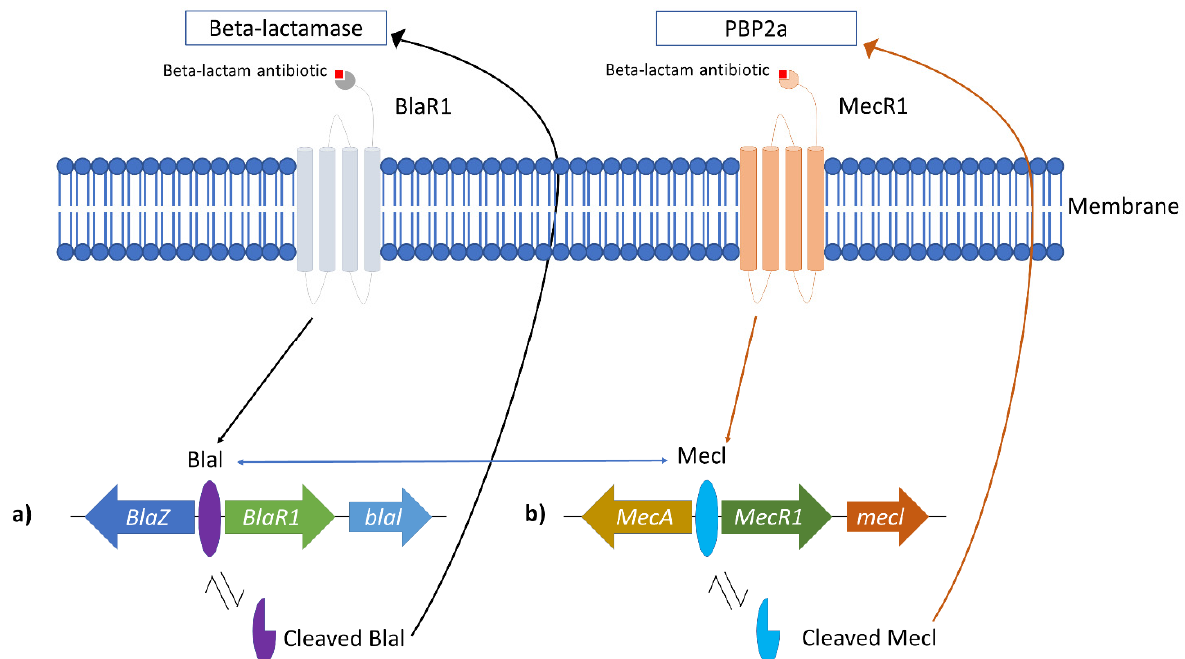
Figure 1. Correlation between Blal and MecA role in MRSA resistance. ( a ) bla operon responsible for beta-lactamase production and ( b ) mec operon responsible for the alteration of normal PBP to PBP2a. The blue arrows indicate that bla and mec operon shared similarities, which allows the repressor (Blal and Mecl) to bind to each operon.